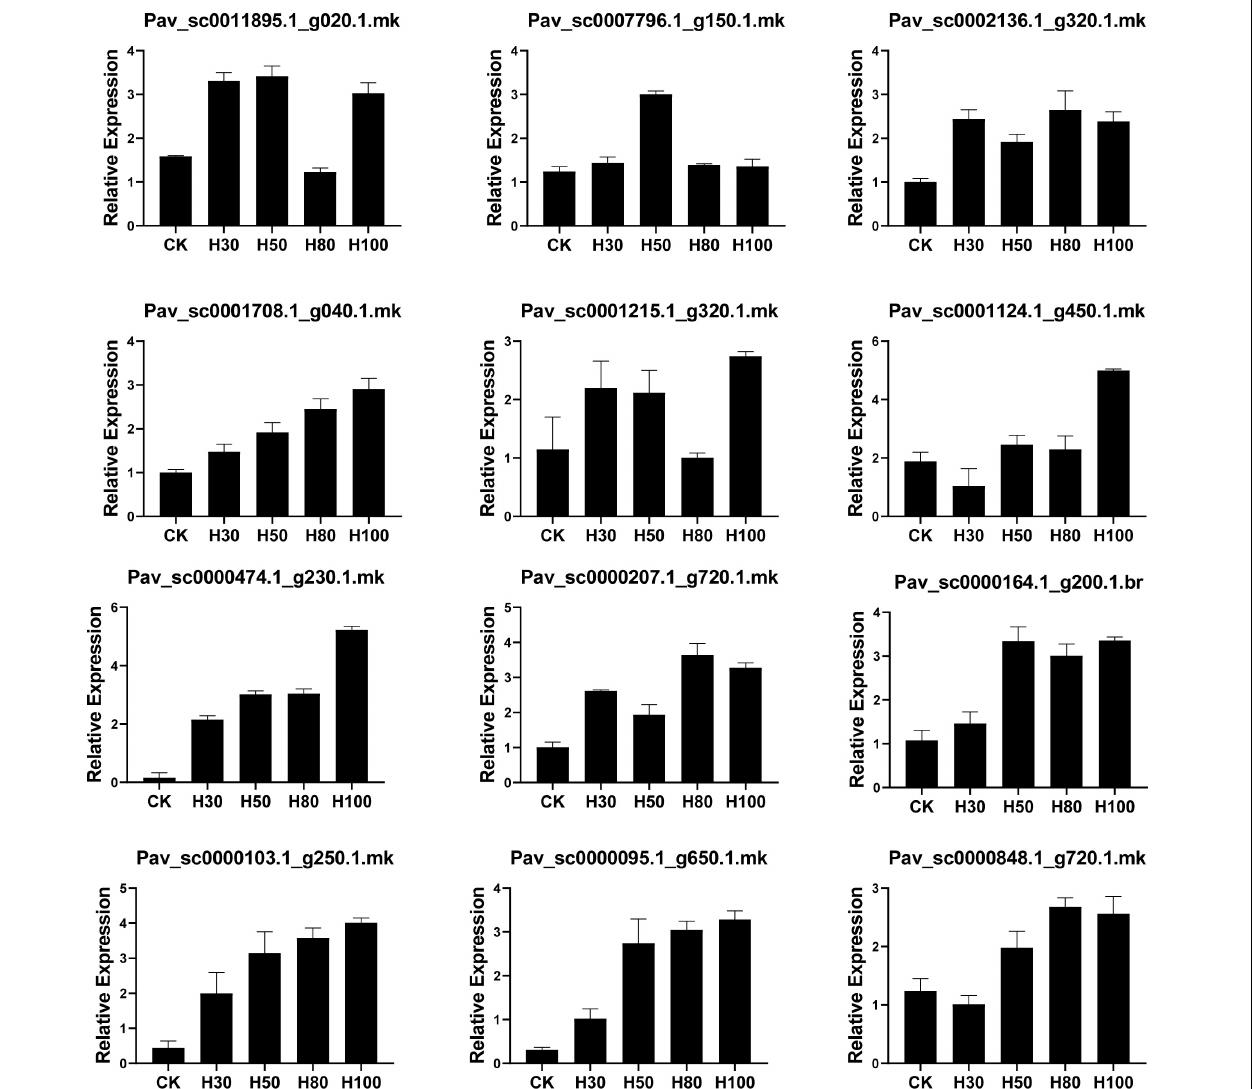
FIGURE 12 | Relative expression behavior of PavGST genes through qRT-PCR on the different time duration of LED implementation on fruit. Mean ± SE of three biological replicates (each having three technical